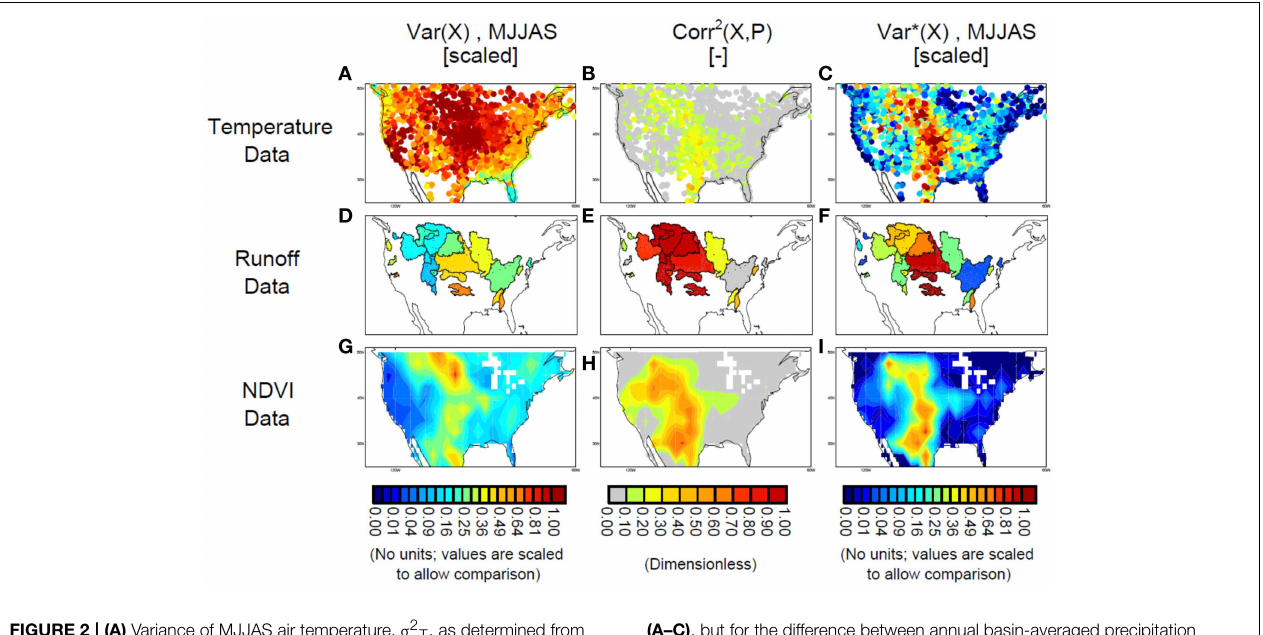
(A–C) , but for the difference between annual basin-averaged precipitation and annual basin-averaged streamflow, and with the correlations computed against annual precipitation. (G–I) Same as (A-C) , but for NDVI data averaged over